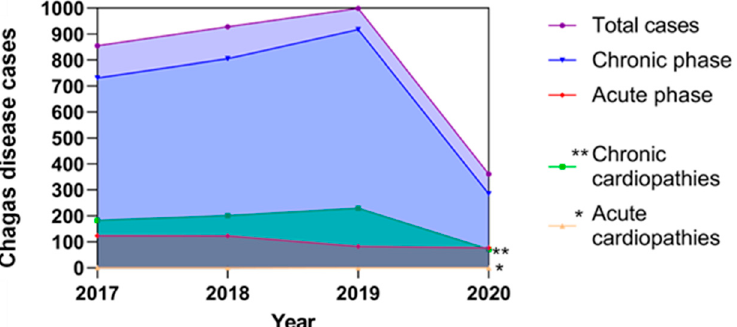
Figure 2. Reported cases of Chagas disease in Mexico and their possible correlations with cardi- opathies from the period